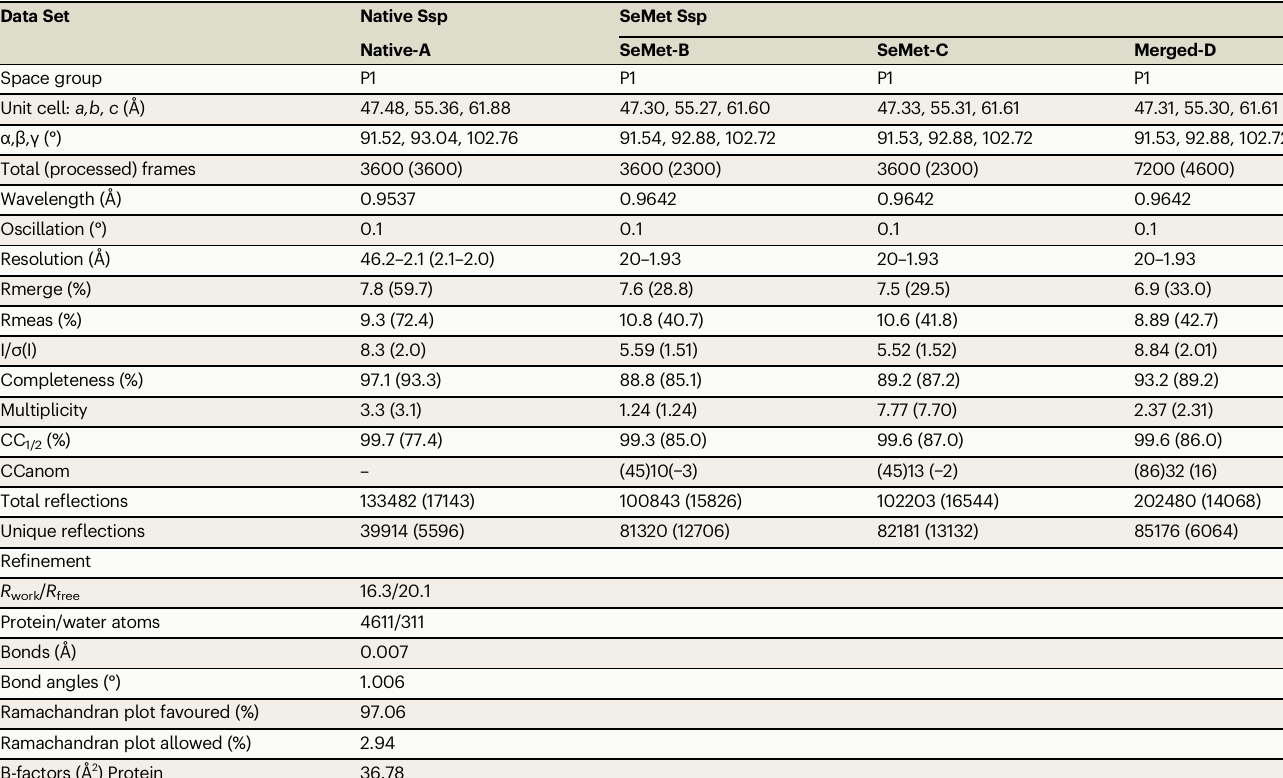
Table 1 | Data collection and re fi nement